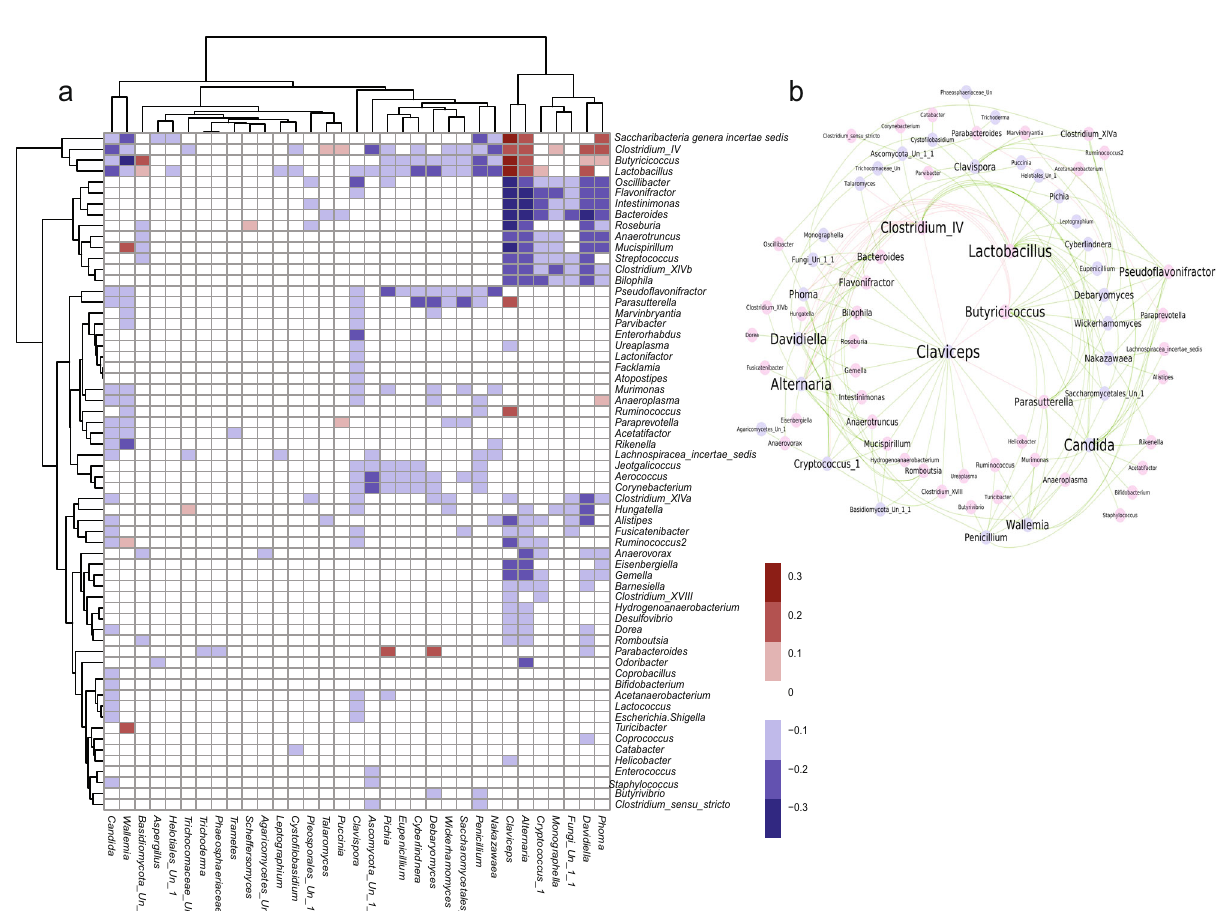
Fig. 3 | Interaction network between microbial standing communities and fungi in the gut of AIL mice. a Heatmap demonstrating signi fi cant (Padj<0.05) correlations between fungal genera (columns) abundances and bacterial genera (rows) abundances (standing communities). The color codes of the cells indicate either positive (purple) or negative (orange) correlations among the species (Padj<0.05); n =419 samples were used for the correlation analysis. b Interaction networkdemonstratingconservedcorrelations(interactionthatispresentforboth standing and active communities; Padj<0.05) between bacterial standing